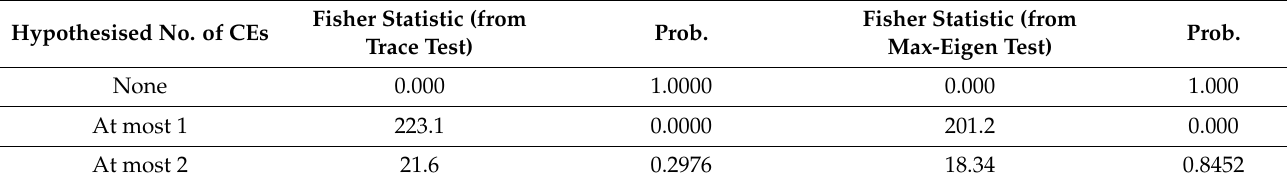
Table 5. Fisher cointegration